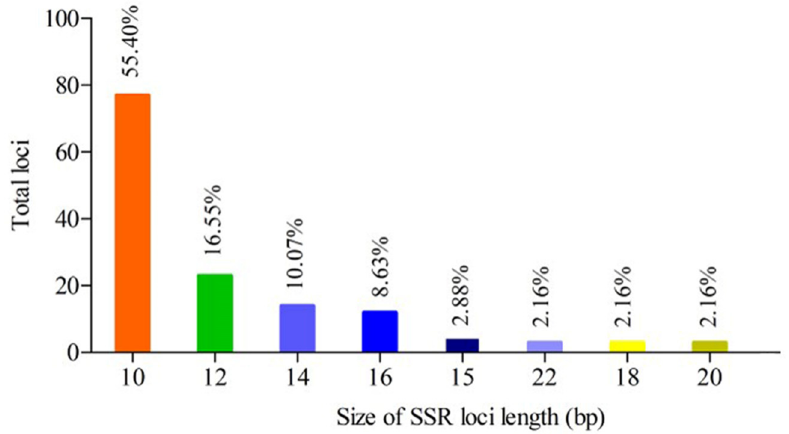
Figure 4. Number and percentage of size of cpSSR loci length for eleven different samples of P. suffruticosa.